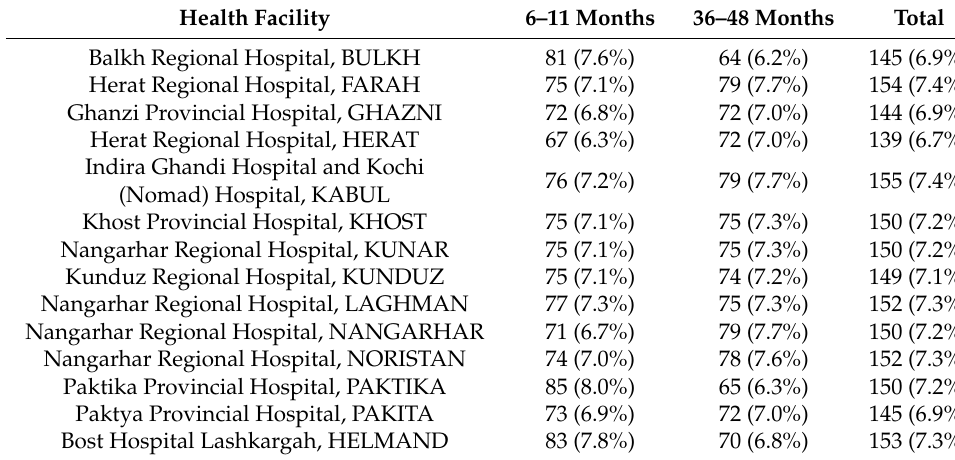
Table 2. Health facilities in targeted